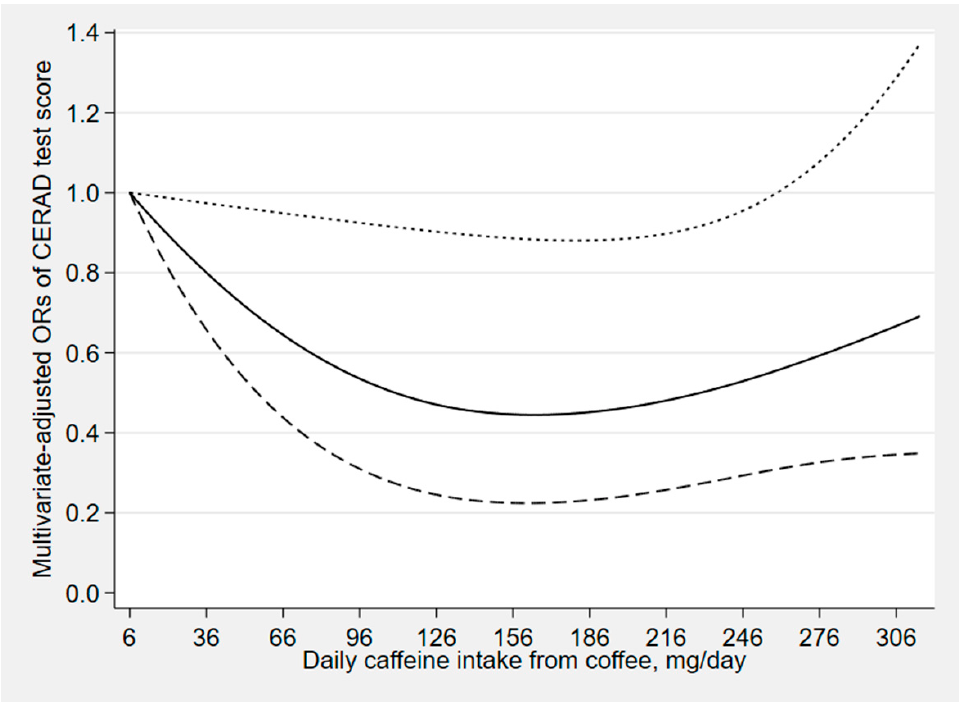
Figure 4. Dose–response relationship between caffeine intake from coffee and CERAD test score. The solid line and dashed line represent the estimated ORs and their 95% confidence intervals (OR, odds ratio).